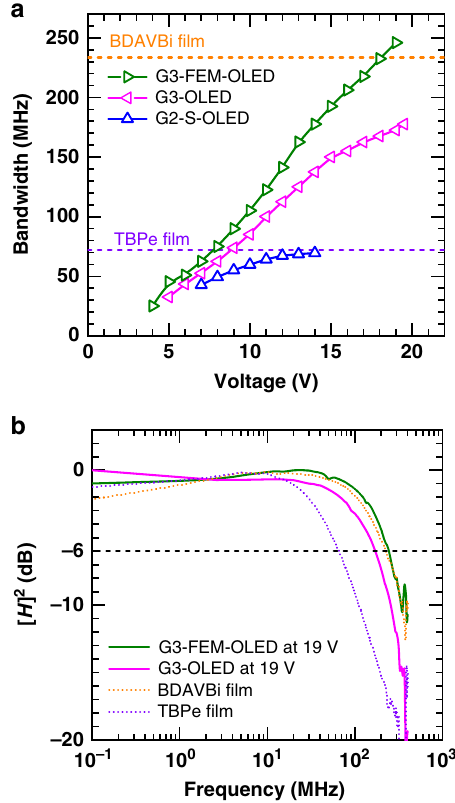
Fig. 3 Frequency characteristics of OLED devices. a Bandwidth as a function of voltage for the three fastest OLED designs, and comparison with the bandwidth of the fi lms (dashed lines). b Frequency response of the OLEDs at 19 V and the fi lms under optical excitation. The black dashed line shows a channel gain [ H ] 2 of − 6